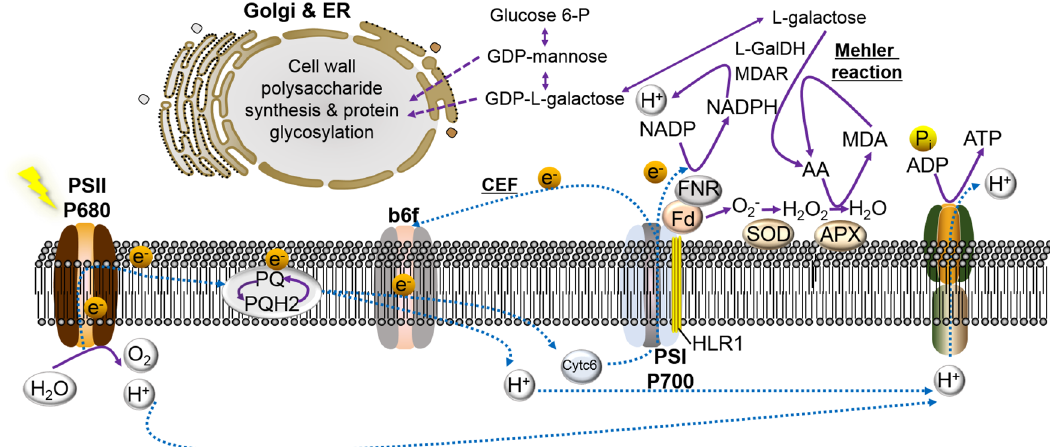
Fig. 5 Schematic of electron fl ow in N. oceanica . AA ascorbic acid, APX ascorbate peroxidase, b 6 f cytochrome b 6 f complex, Cyt C 6 cytochrome c 6 complex, Fd ferredoxin, FNR ferredoxin-NADP reductase, L-GalDH L-galactose dehydrogenase, MDA monodehydroascorbate, MDAR monodehydroascorbate reductase, PQ and PQH2 plastoquinone and reduced plastoquinone, PSII and PSI photosystem II and I, SOD superoxide dismutase. See Supplementary Fig 10 and Supplementary Data 7 for details of the transcriptional dynamics of genes involved in cell wall biosynthesis, protein glycosylation, and AA